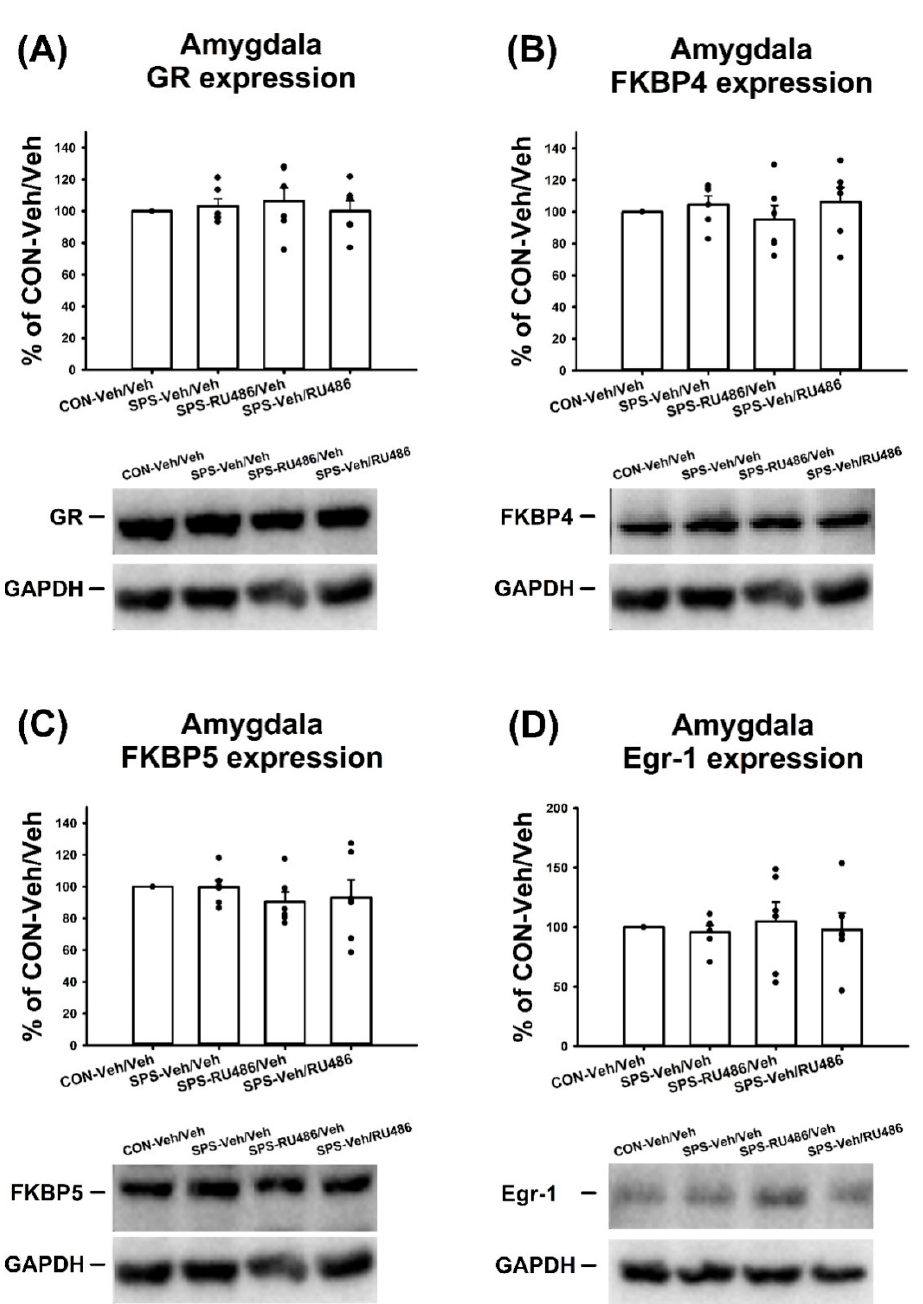
Figure 5. The expressions of the ( A ) GR, ( B ) FKBP4, ( C ) FKBP5, and ( D ) Egr-1 in the amygdala after SPS paradigm and early/late RU486 intervention. The data represent the mean ± SEM. n = 6 for each group. Statistical analysis was employed with a one-way ANOVA followed by Bonferroni post hoc testing.